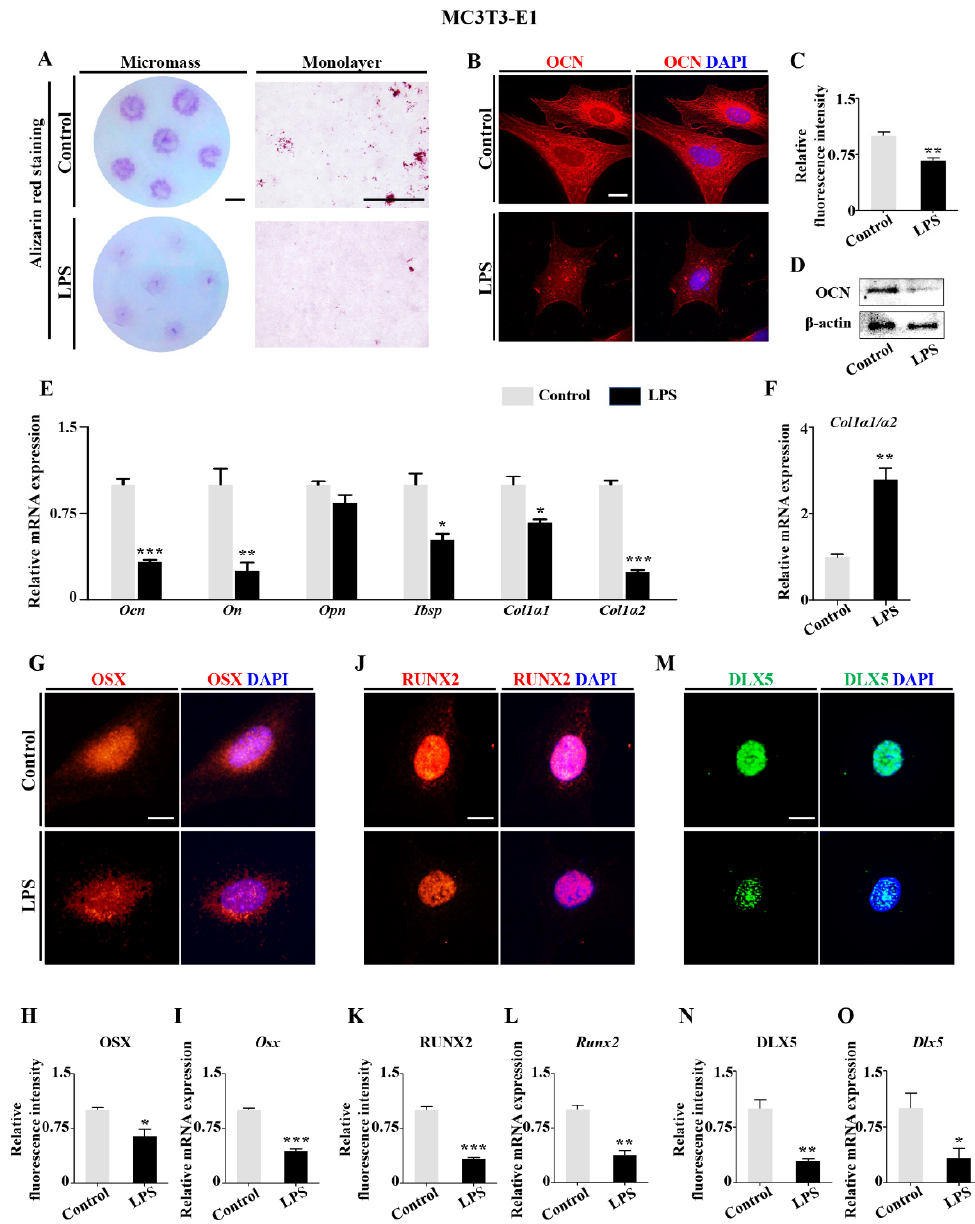
Figure 5. Assessment of the di ff erentiation of MC3T3-E1 cells following LPS treatment. ( A ) Representative images of alizarin red staining of MC3T3-E1 cell mass cultures (left panels) or monolayer cultures after cultured for 21 days (right panels) of the control and LPS groups. ( B , C ) Representative images of OCN immunofluorescent staining on MC3T3-E1 cells counterstained with DAPI in control and LPS-treated groups Negative controls were shown in Supplementary Materials (Figure S7). ( B ). OCN expression was quantified with fluorescence intensity ( C ). ( D ) Western blot data showing OCN expression of control and LPS-treated MC3T3-E1 cells. ( E , F ) qPCR data showing the expressions of Ocn , On , Alpl , Ibsp , Col1 α 1 , Col1 α 2 , and Col1 α 1 / Col1 α 2 in control and LPS-treated MC3T3-E1 cells. ( G , J , M ) Representative images of DLX5 ( G ), RUNX2 ( J ), and OSX ( M ) immunofluorescent staining on MC3T3-E1 cells, counterstained with DAPI. Negative controls were shown in Supplementary Materials (Figure S7). ( H , K , N ) Fluorescent staining intensities of DLX5 ( H ), RUNX2 ( K ), and OSX ( N ) of control and LPS-treated MC3T3-E1 cells. ( I , L , O ) qPCR data showing the mRNA expression of Dlx5 , Runx2 , and Osx in control and LPS-treated MC3T3-E1 cells. Scale bars = 5 mm in ( A ); 20 µ m in ( B , G – M ). (* p < 0.05, ** p < 0.01, *** p < 0.001)